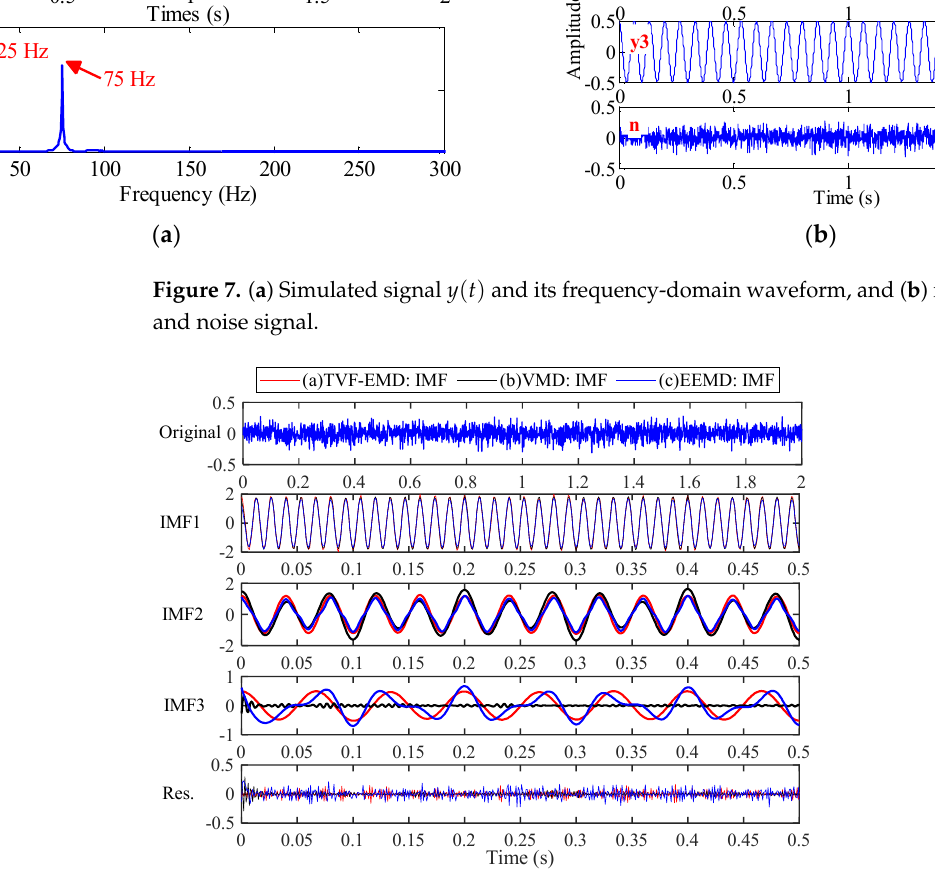
Figure 8. The decomposition results of simulated signal y ( t ) obtained by: ( a ) red line: TVF-EMD; (b) black line: VMD; (c) blue line: EEMD.